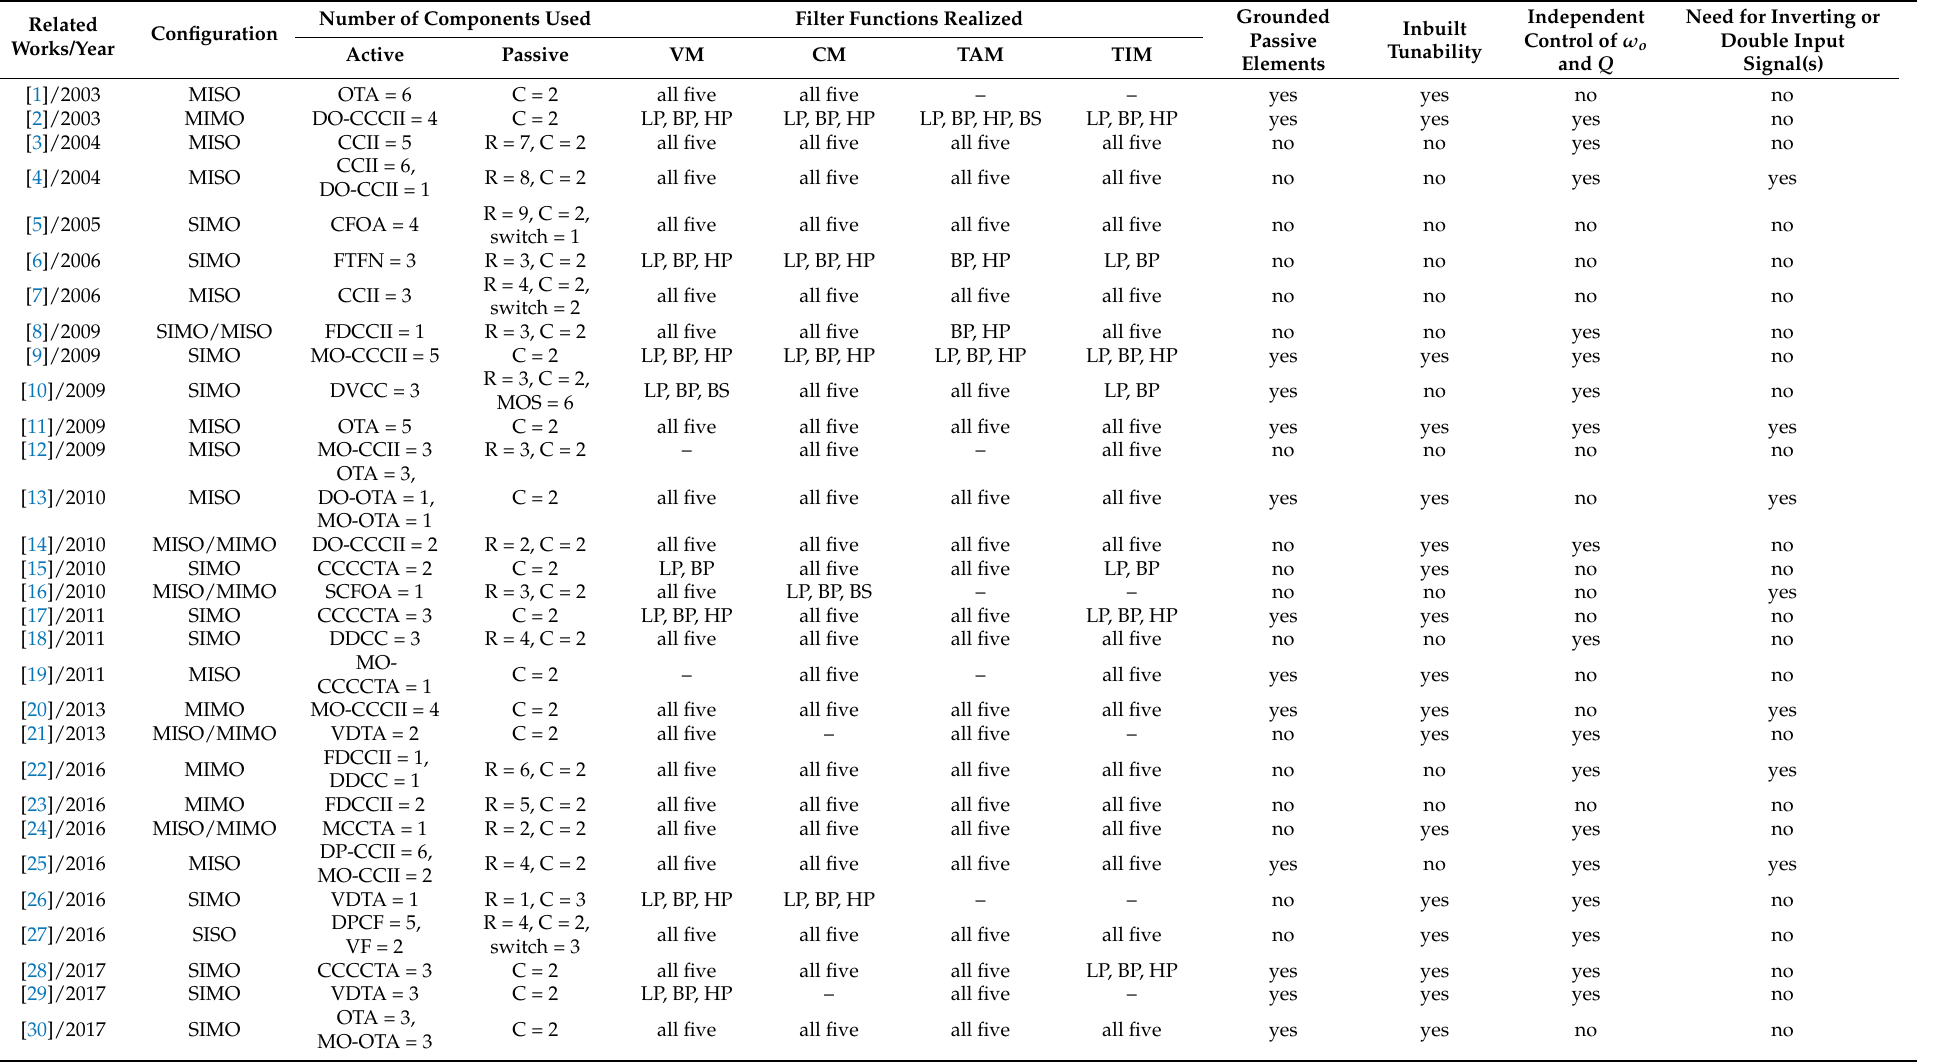
Table 1. A comparison chart of previously related mixed-mode universal biquad